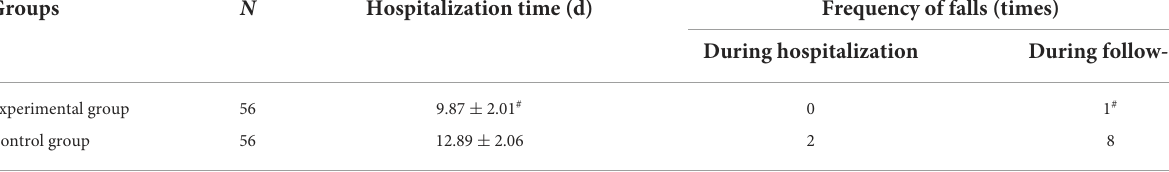
TABLE 2 Comparison of hospital stay and frequency of falls between two groups. Groups N Hospitalization time (d) Frequency of falls (times) During hospitalization During follow-up Experimental group 56 9.87 ± 2.01 # 0 1 # Control group 56 12.89 ± 2.06 2